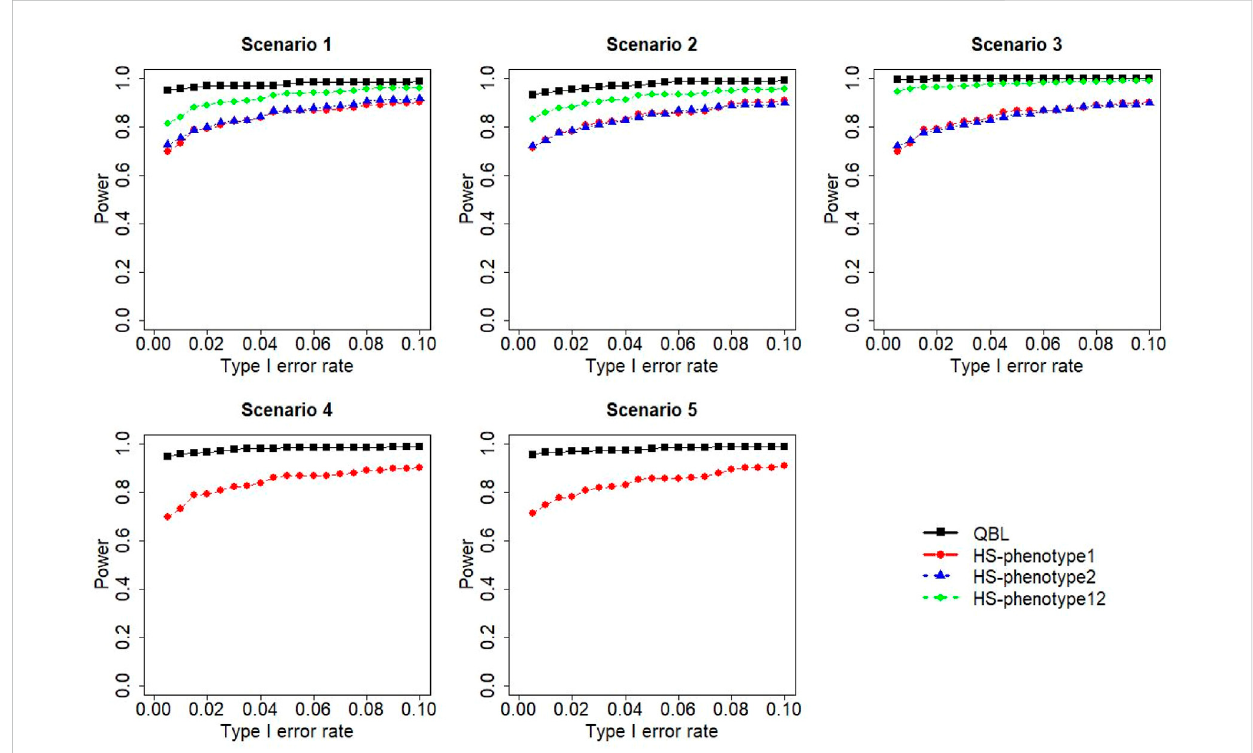
Table 1; σ c (cid:1) σ c ′ (cid:1) 1 and ρ are varied to be 0 . 1 , 0 . 5 , or 0 . 9. We set β (cid:1) β (cid:1) 0 c 0 c ′